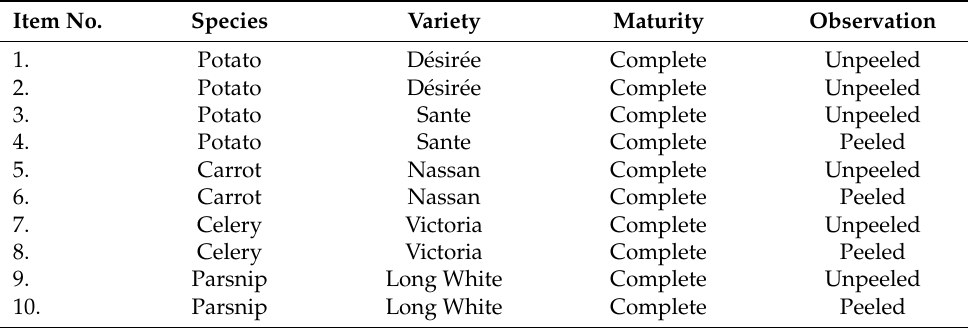
Table 2. Vegetable species and varieties analyzed by the method of texture analysis [22]. Item